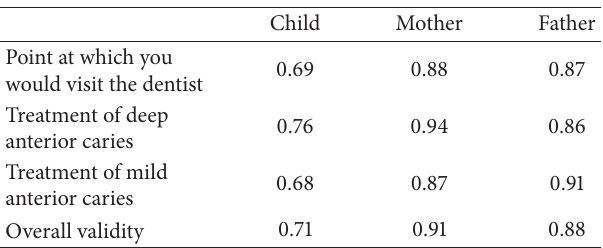
Table 1: Validity statistics of the tool ∗ .